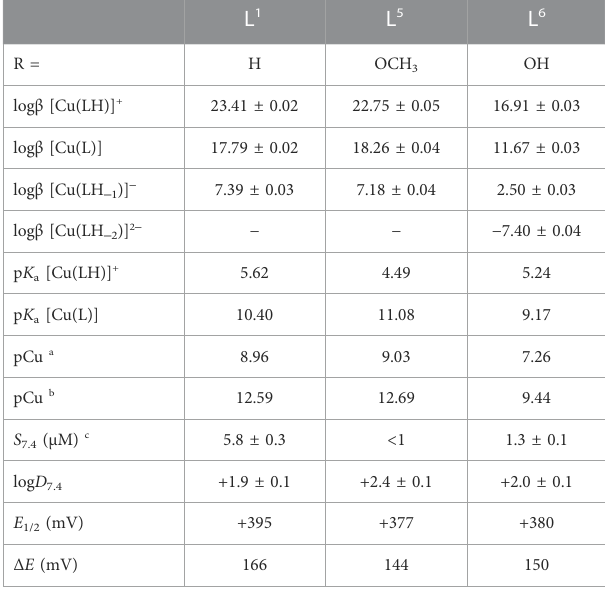
TABLE 3 Overall (log β ) stability and proton dissociation (p K a ) constants of the Cu(II) complexes formed with L 1 , L 5 and L 6 determined by